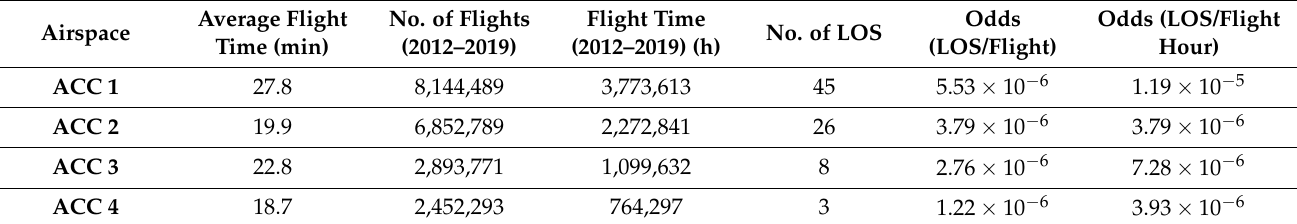
Table 1. Odds for LOS/Flight and LOS/Flight hour per